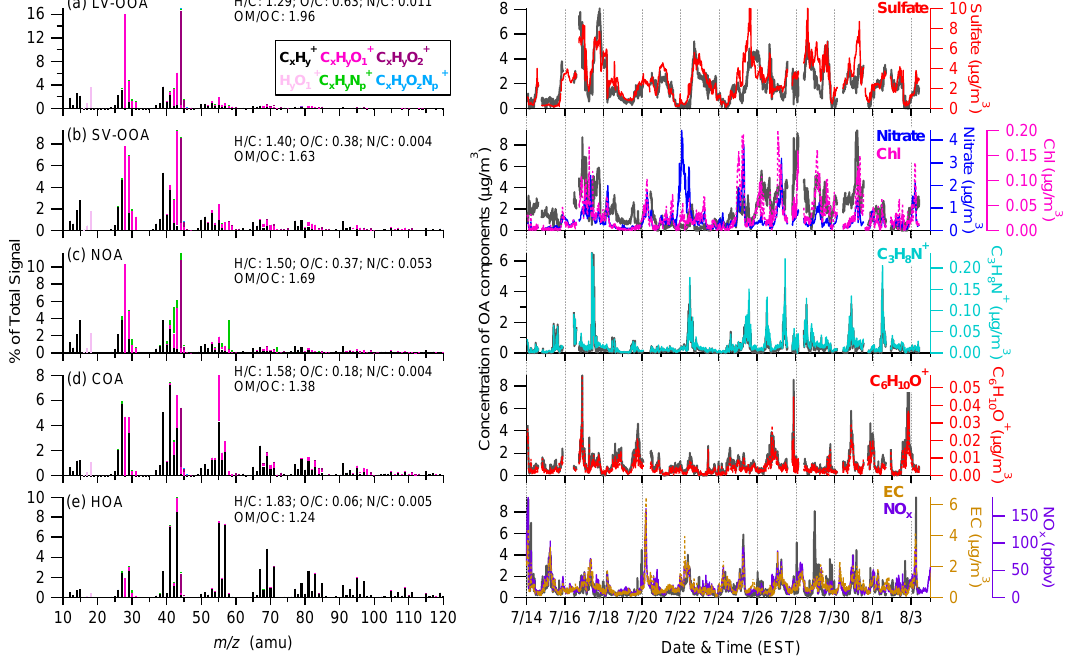
Fig. 8. HRMS (left) and time series (right) of OA components: (a) low-volatility oxygenated OA (LV-OOA) (b) semi-volatile OOA (SV- OOA), (c) nitrogen-enriched OA (NOA), (d) cooking-emission OA (COA), and (e) hydrocarbon-like OA (HOA). Also shown are the corre- sponding time trends of tracer compounds, i.e., sulfate for regional secondary species in (a) ,nitrate and chloride for semi-volatile secondary species in (b) , C 3 H 8 N + as a tracer ion for amine-type of compounds in (c) , C 6 H 10 O + as a tracer ion for cooking aerosols in (d) , and EC and NO x as tracers for combustion emissions in (e) . The elemental ratios and OM/OC ratio of each component are also shown in the